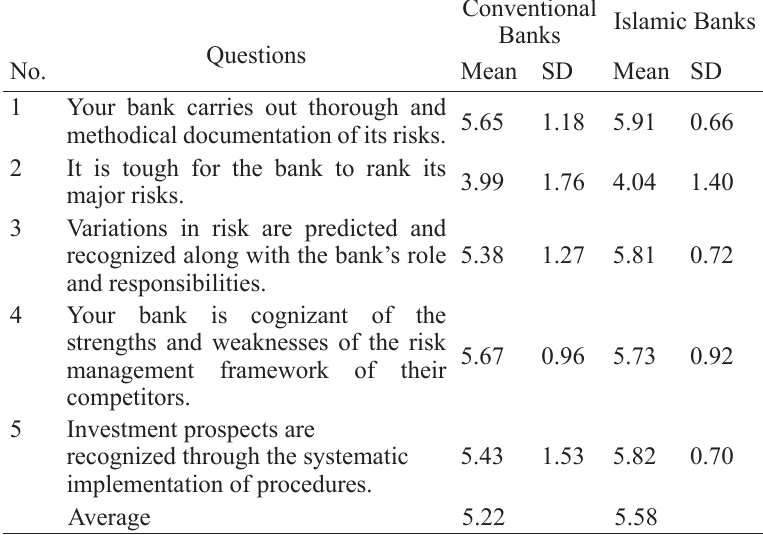
Responses to Questions about the RI